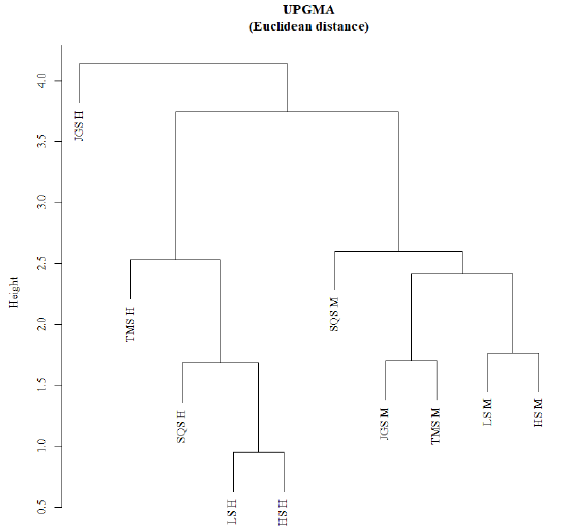
Figure 4. Cluster analysis based on needle traits in five populations of P. massoniana and P. hwangshanensis . Abbreviations: SQS, Mt. Sanqingshan; LS, Mt. Lushan; JGS, Mt. Jinggangshan; HS, Mt. Huangshan; TMS, Mt. Tianmushan. M, P. massoniana ; H, P. hwangshanensis .